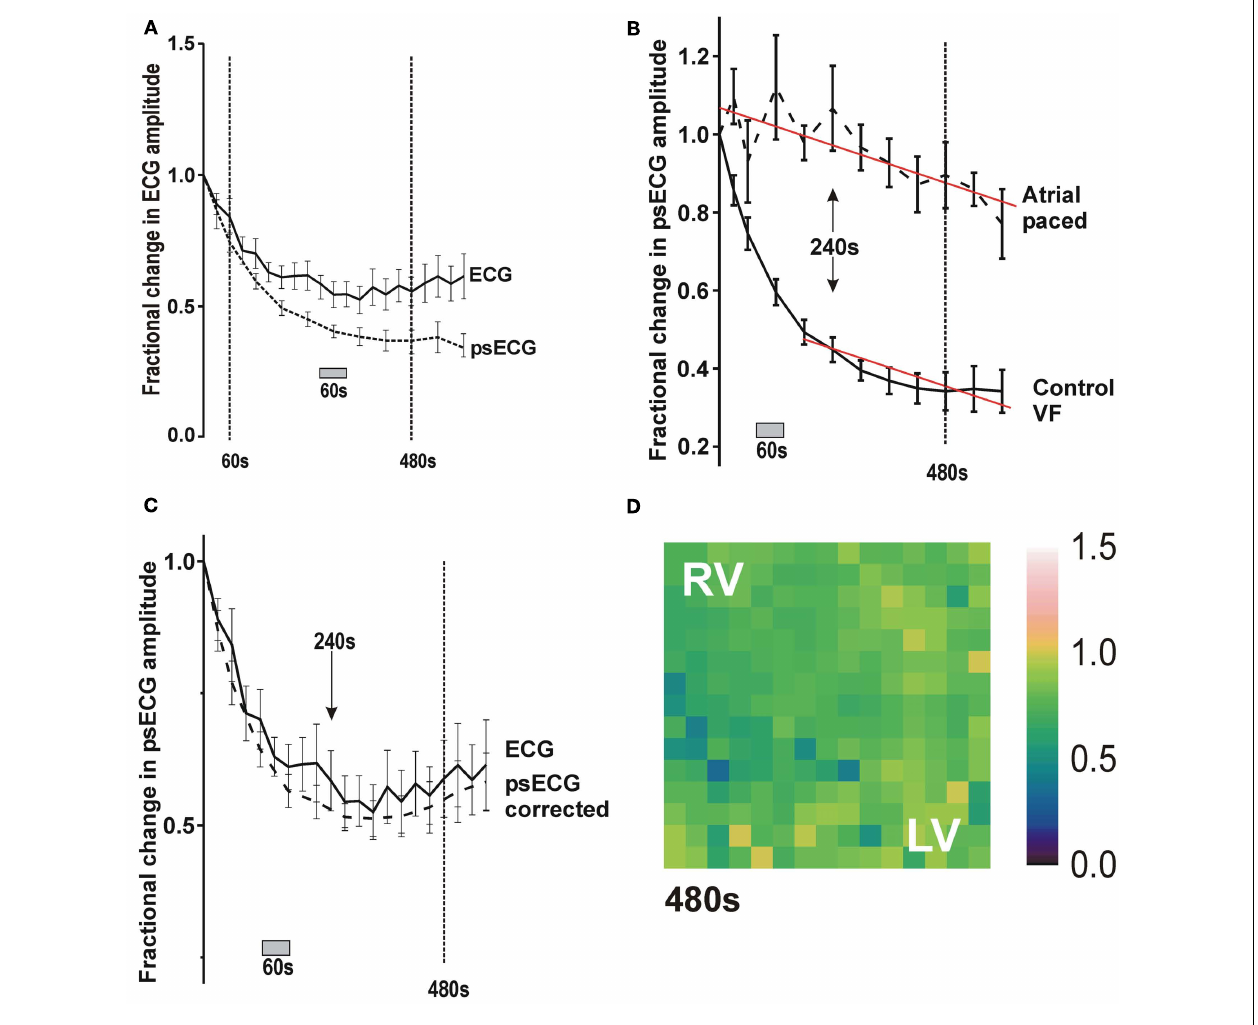
signal amplitude with time during atrial pacing and duringVF in control conditions. (C) Plot of amplitude changes in ECG and corrected optical signal in control conditions. (D) Color map of the fractional change in amplitude during RA pacing after 480s.